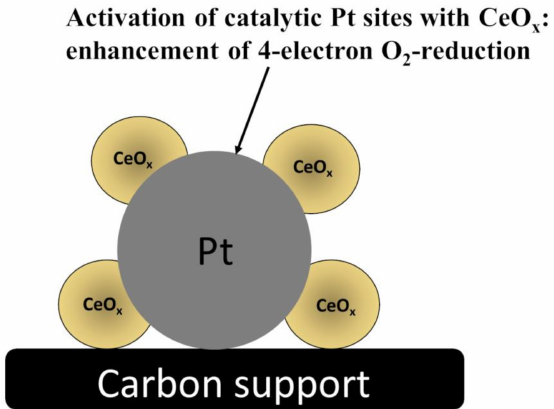
Figure 2. Decoration of Pt nanoparticles with CeO x nanostructures. Due to the metal (Pt)—Metal oxide (CeO x ) specific interactions, platinum is stabilized in its metallic catalytic state [22,23].